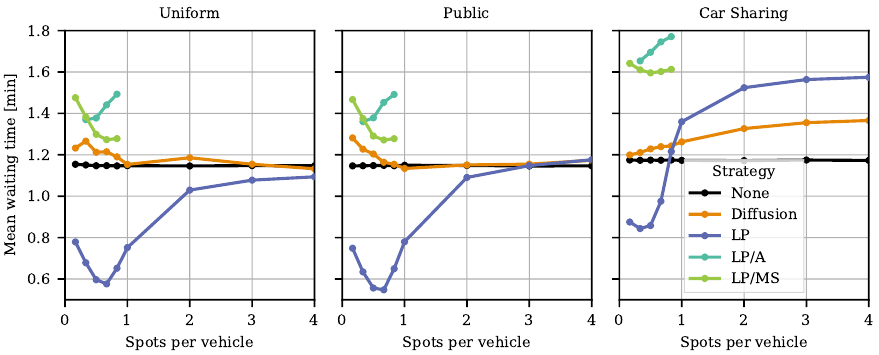
Figure 4. Evolution of the mean waiting time for the different parking strategies depending on the number of parking spaces and their distribution. (A = Depot at airport; MS = depot at the main station).